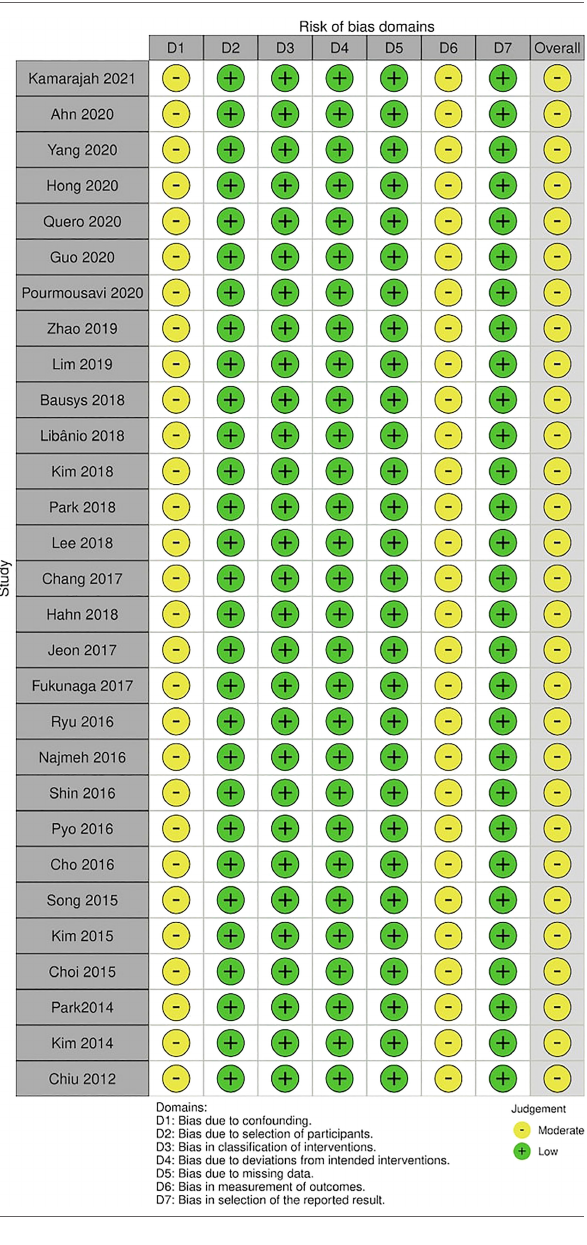
TABLE 2 | Risk of bias assessment assessed